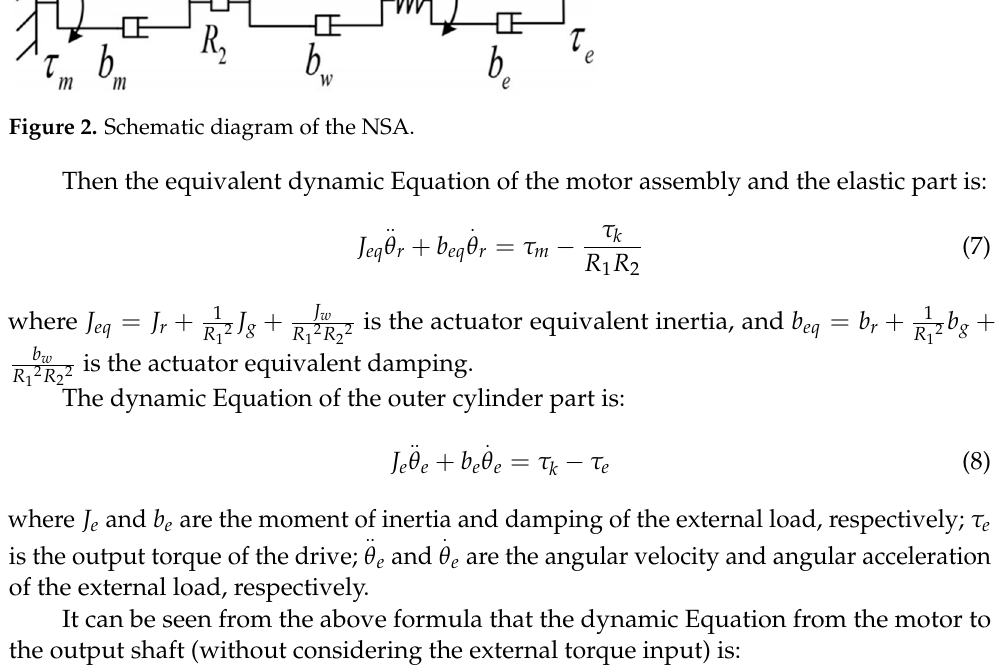
Figure 3. The schematic of TSM controller.